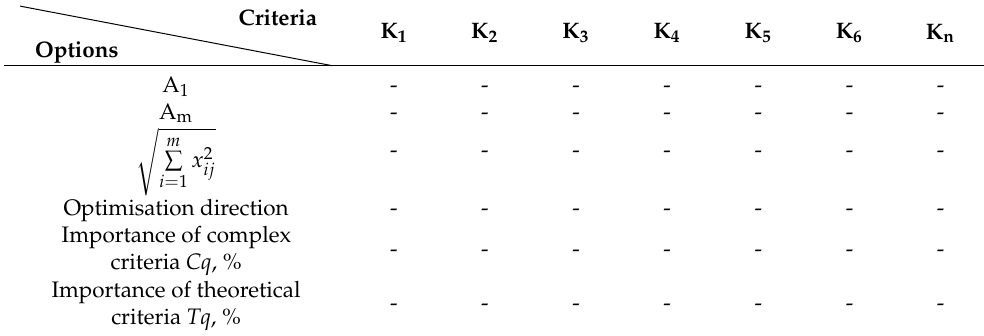
Table 13. The initial Matrix M of alternative solutions.